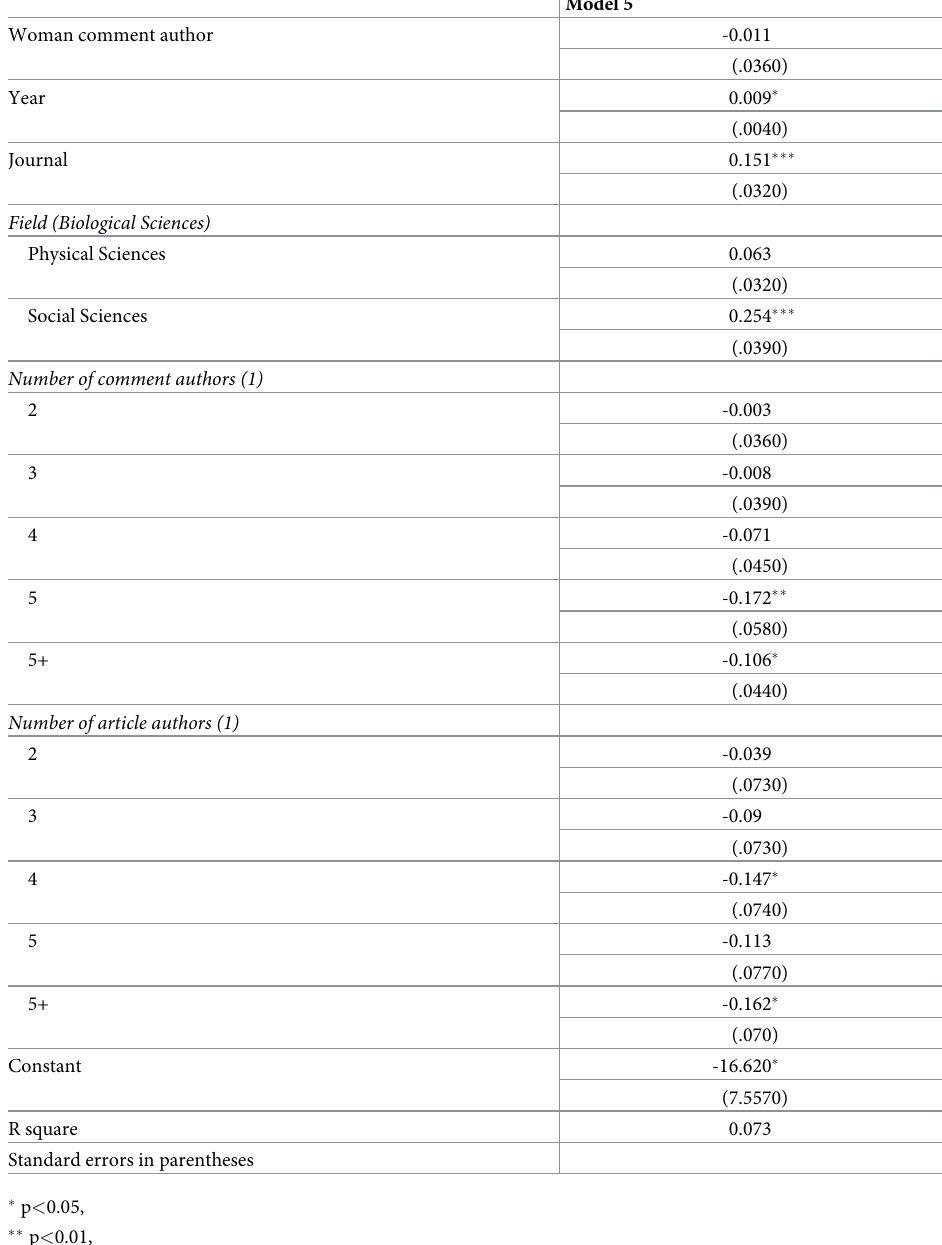
Table 2. Linear probability estimates that first author of target article is corresponding